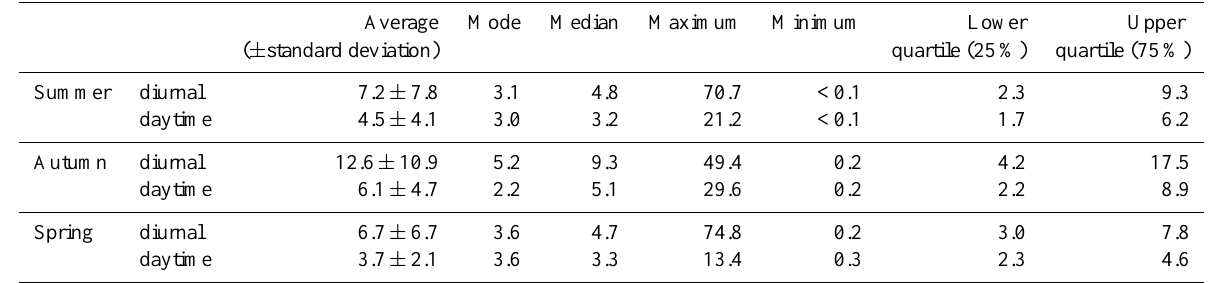
Table 5. Seasonal variations of diurnal and daytime (no temperature inversions) mean 222 Rn concentrations along the Trans-Siberian Railway (in Bqm − 3 ) . Average Mode Median Maximum Lower ( ± standard